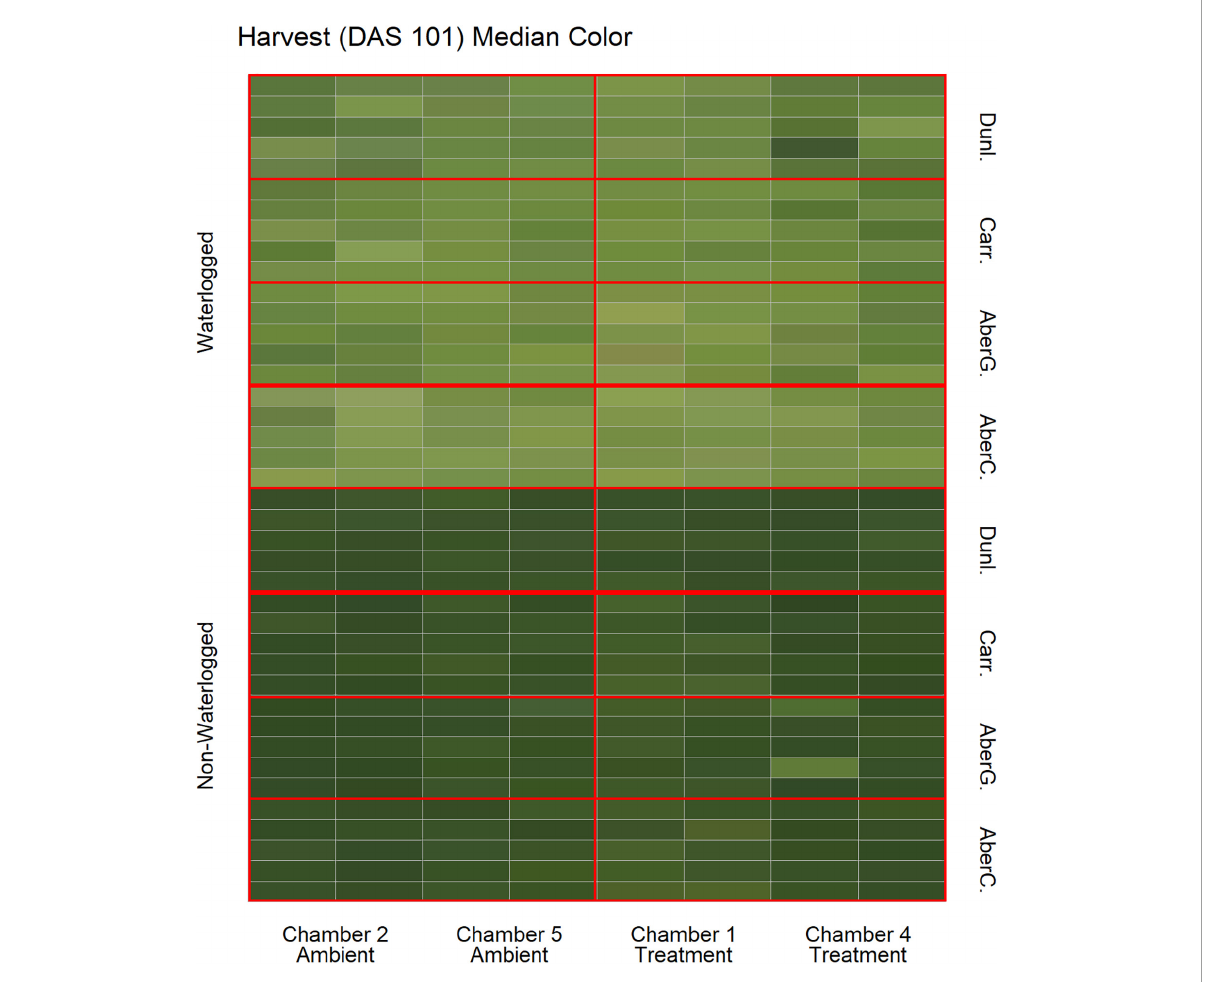
FIGURE4 Median color (RGB) of the harvested material for all cores on DAS 101 as identified by the image analysis, sorted on water status, climate treatment and variety. Each cell represents the median true color of the harvested material of a plant. AberC, Aberchoice; AberG, Abergain; Carr, Carraig; Dunl,